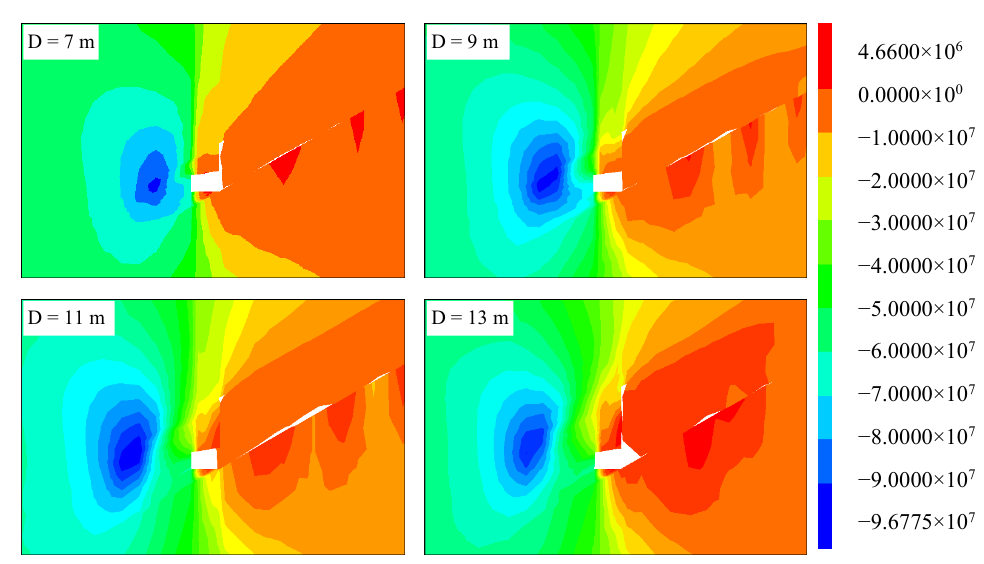
Figure 10. Relationship between depth of roof-cutting and stress concentration position.